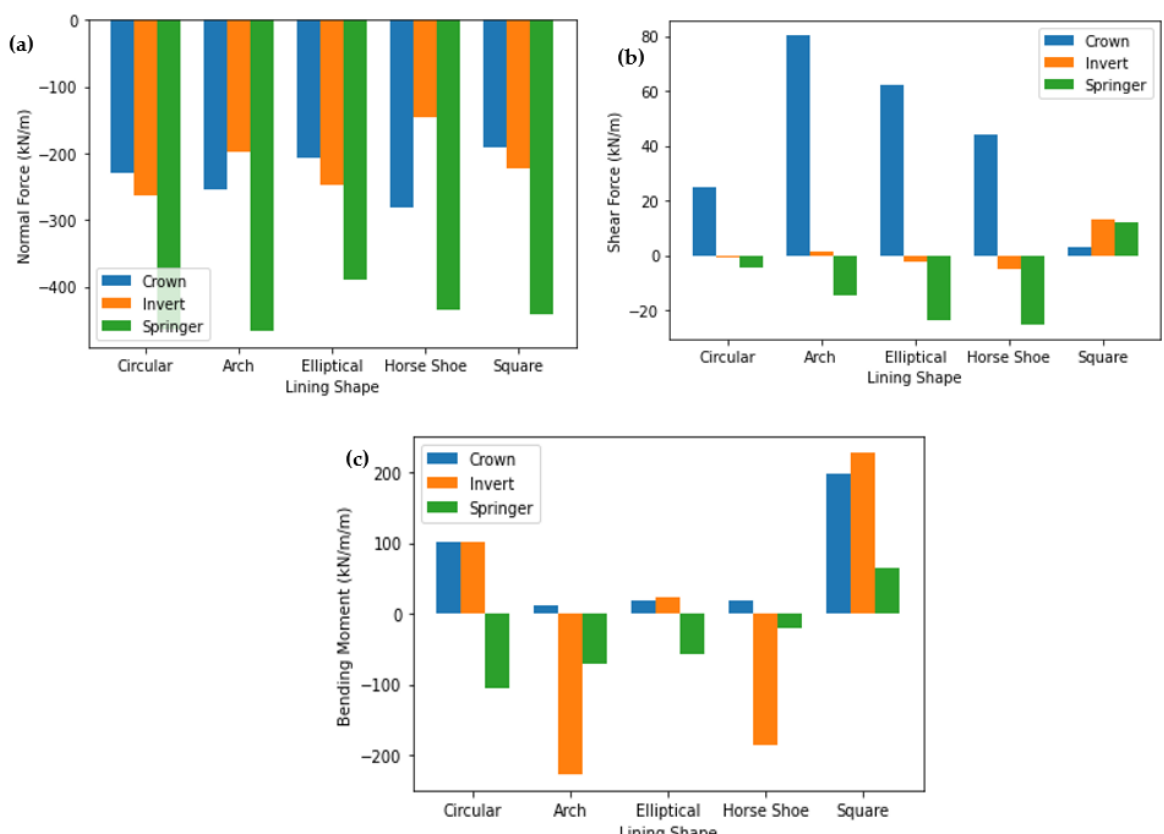
Figure 17. Variation of ( a ) normal force, ( b ) shear force, and ( c ) bending moment for the crown, springer, and invert locations for different tunnel openings represented on the horizontal axis.